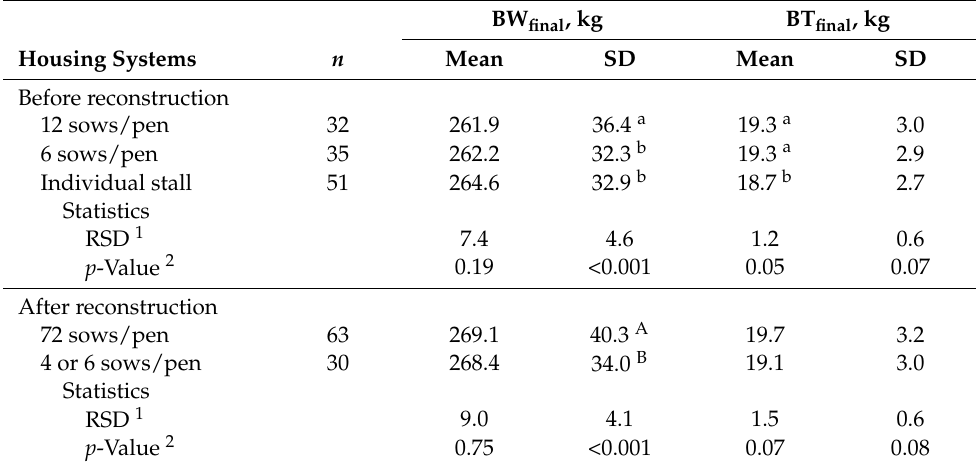
Table 3. Overall mean and standard deviation (SD) of body weight (BW final ) and backfat thick- ness (BT final ) at farrowing calculated per batch in different housing systems before and after the reconstruction period on the farm. BW final , kg BT final ,